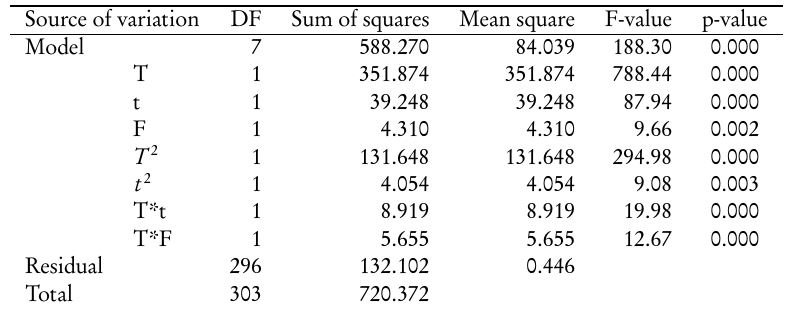
ANOVA table of the final model for material A. T = Temperature, t = Time, F = Force per cm 2 .